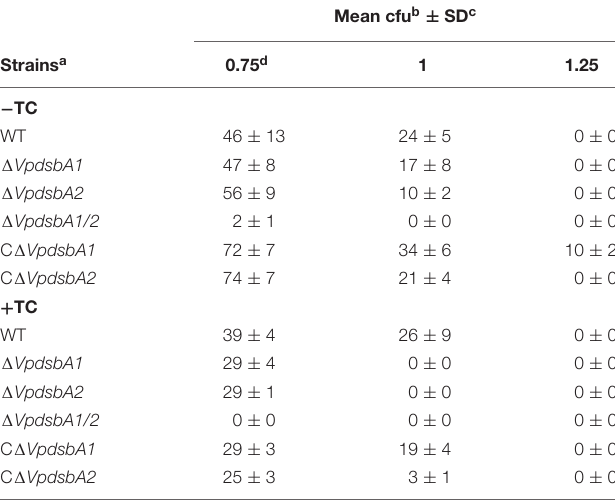
TABLE 3 | Cadmium sensitivity assay of V. parahaemolyticus WT and mutant